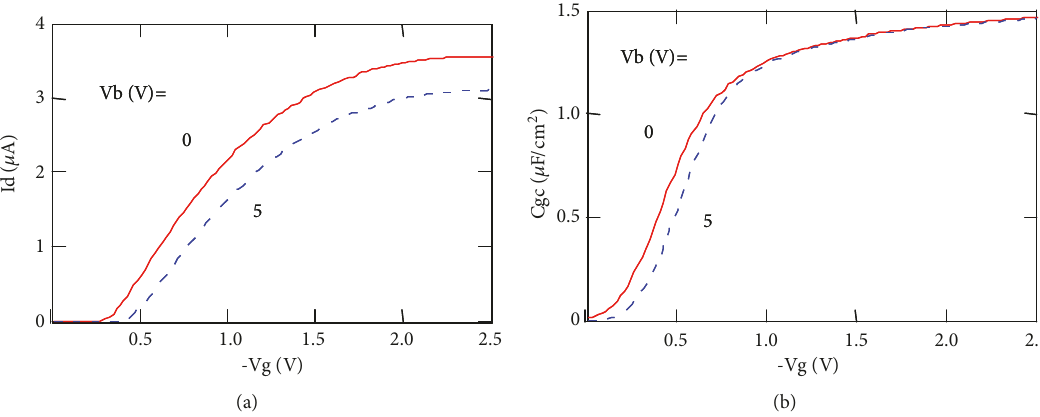
( V ) (a) and C ( V ) (b) characteristics obtained on p type FD-SOI MOSFETs for two substrate voltages V d g gc g